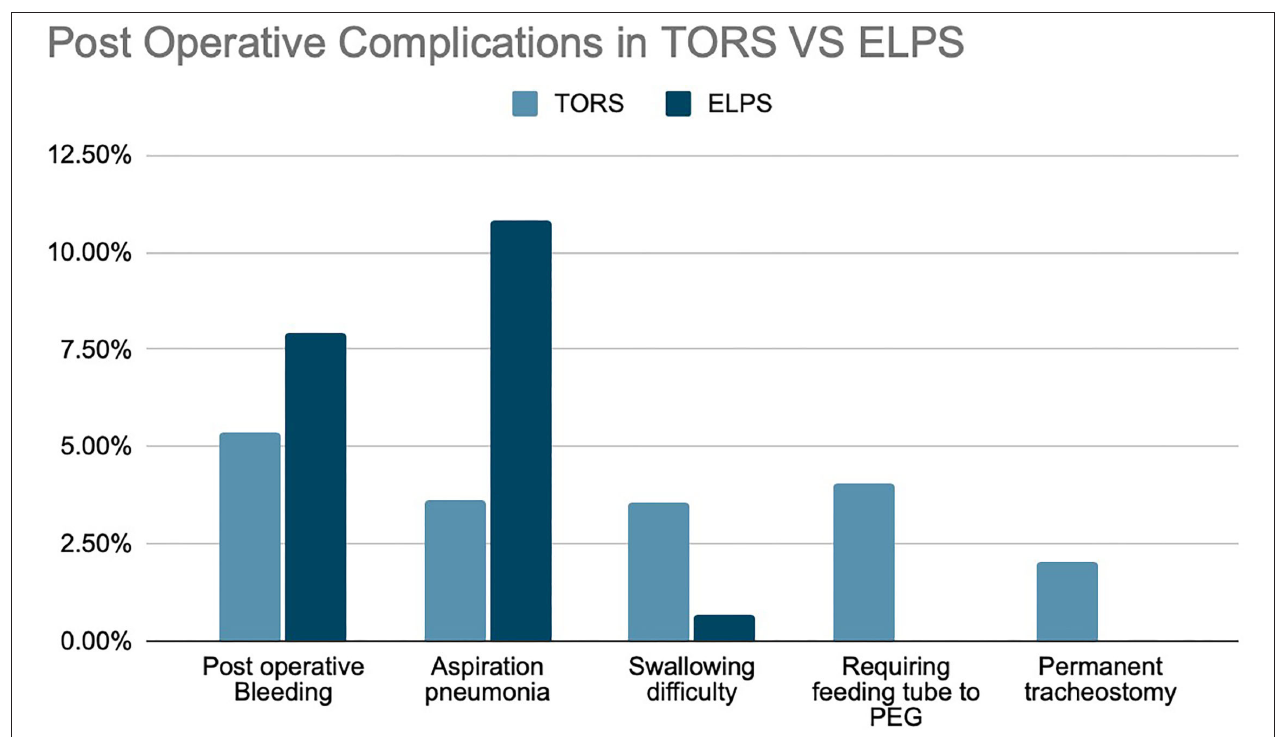
FIGURE 9 | Post-operative complications between TORS and ELPS.